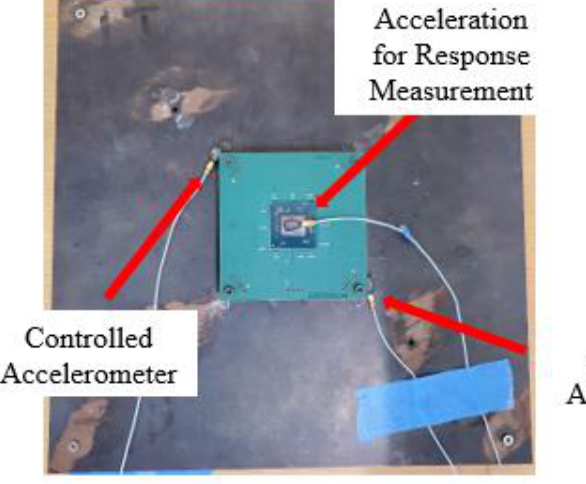
Figure 7. Detail of the test vehicle.